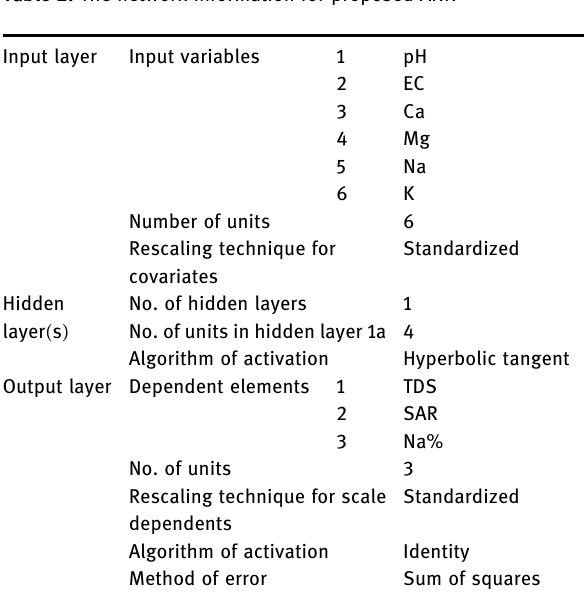
Table 3: The statistical results of the ANNs